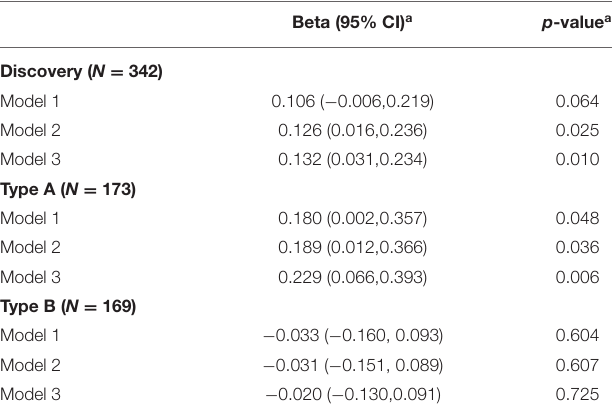
TABLE 4 | Association rs13019803C between sST2 in type A AD patients ( N = 463).